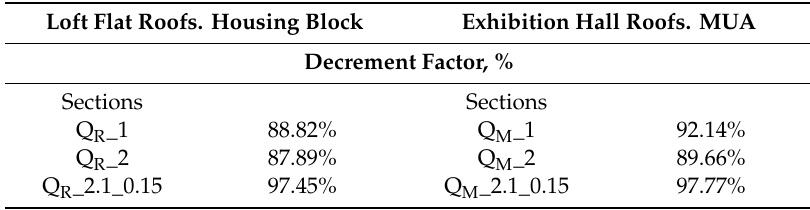
Table 11. Decrement factor values of the roof sections under study.